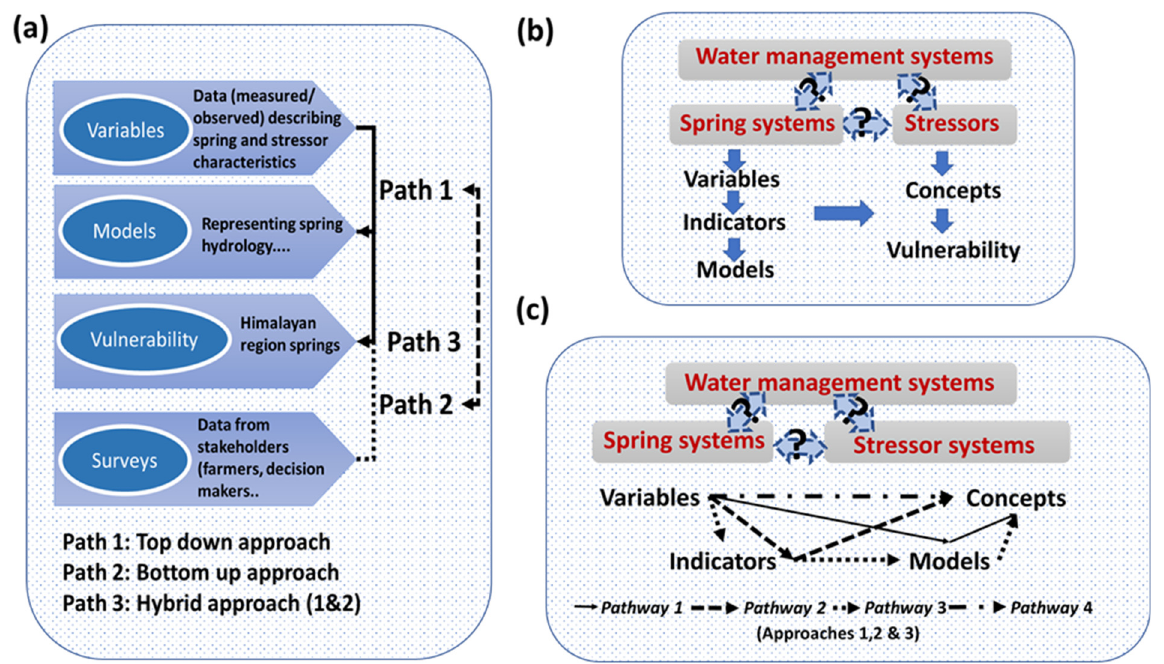
Figure 1. Vulnerability of Himalayan springs to variable and changing stressors. ( a ) Three approaches (based on starting points) that can be used in vulnerability assessments. ( b ) Systems approach to represent the triple complexity. ( c ) Approaches and pathways to representing the complexity in IHR. In ( b ) and ( c ), the inter-connectedness between the three systems is represented using dashed-bordered arrows. The solid-bordered arrows in ( b ) represent the general information flow while translating variables to the vulnerability concept. The first column of solid-bordered arrows (left-hand side) in ( b ) represents the water management systems and stressor systems, while the second column of solid-bordered arrows (right-hand side) in ( b ) represents the vulnerability of the water management system. The information flow through solid-bordered arrows in ( b ) is divided into four pathways using 4 arrow types in ( c ).